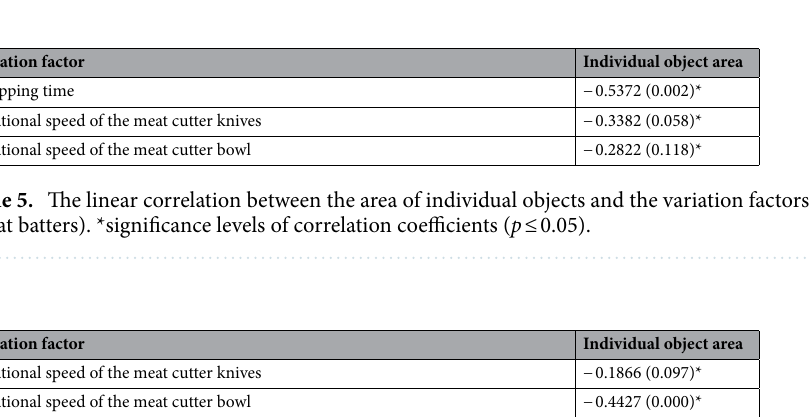
Table 4. The linear correlation between the parameters of the dimensions of fat particles in the meat batter and the rotational speed of the cutter knives and bowl. *significance levels of correlation coefficients ( p ≤ 0.05).